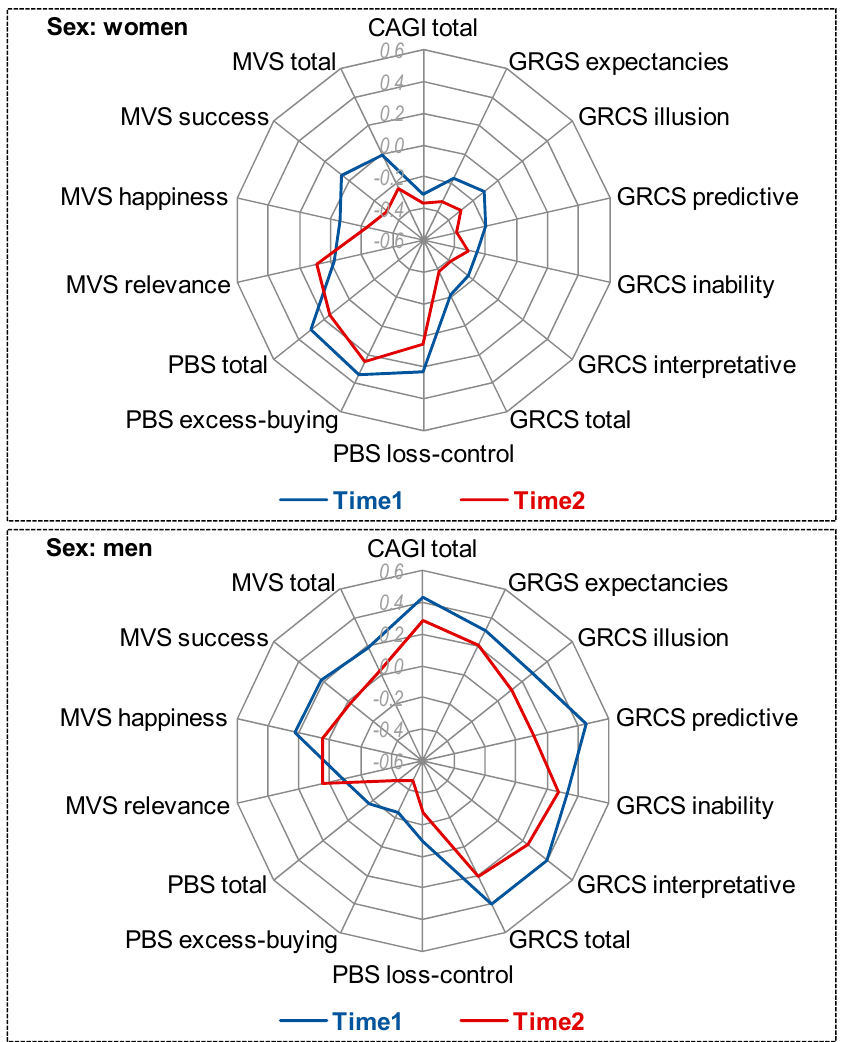
Figure 2. Radar chart stratified by gender (standardized means). CAGI: Canadian Adolescent Gambling Inventory. GRCS: Gambling − Related Cognitions Scale. PBS: Pathological Buying Screener. MVS: Materialism Values Scale.